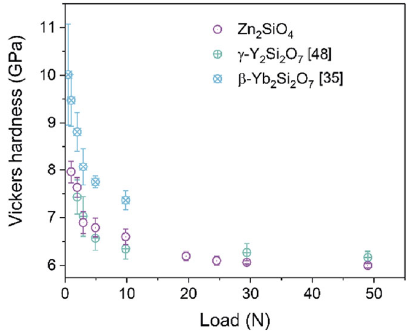
Fig. 6 Load-dependent Vickers hardness of Zn 2 SiO 4 , γ -Y 2 Si 2 O 7 [48], and β -Yb 2 Si 2 O 7 [35] at room